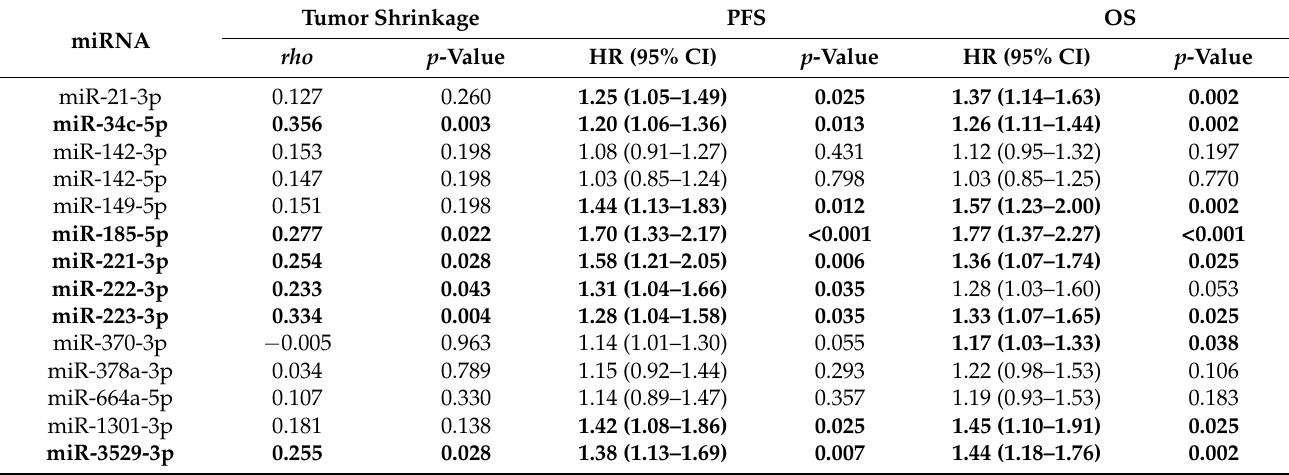
Table 3. Correlation of 14 miRNAs with tumor shrinkage, PFS and OS since start of first-line VEGFR-TKI therapy.